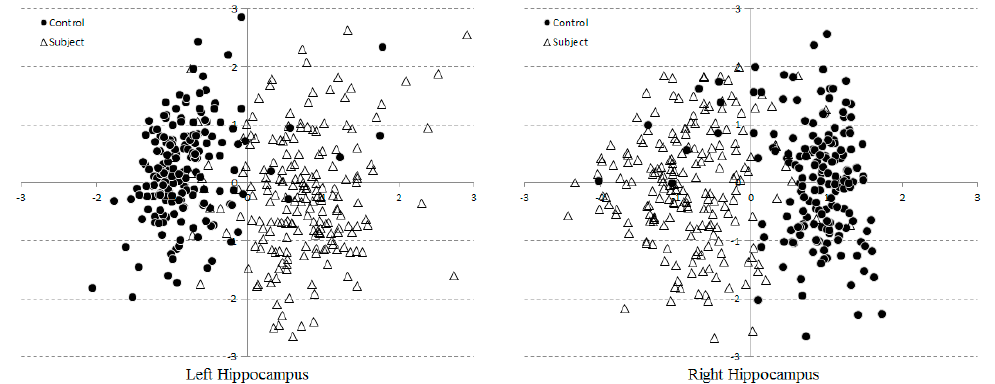
Figure 5. Scatter plots of two model parameters extracted from 382 hippocampi. Horizontal and vertical axes represents the first and second modes of variations, respectively.